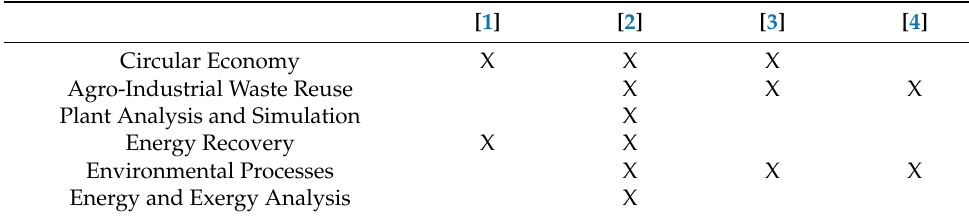
Table 1. Correlation matrix of the selected